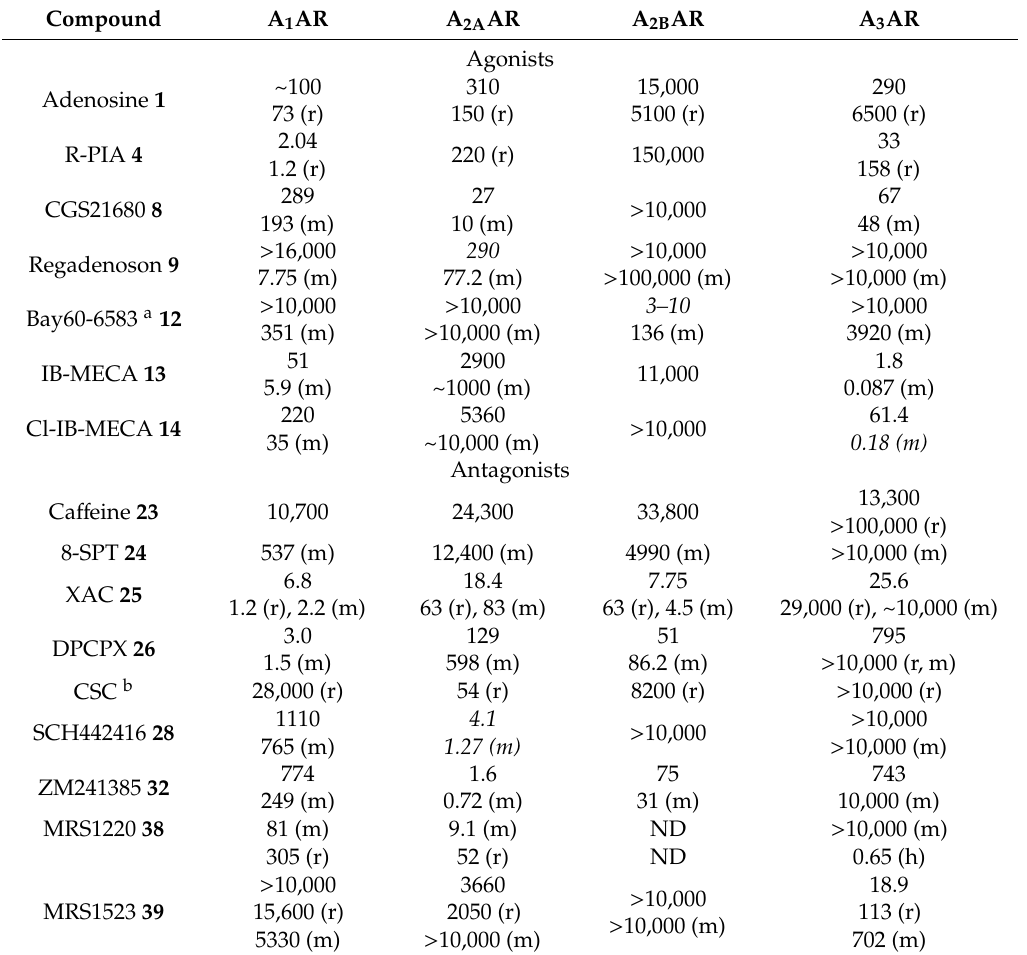
Table 1. A ffi nities of selected AR ligands (K i , nM) that have been used to define adenosinergic activities of non-adenosine receptor drugs (refer to Figure 2 for most structures). Species are human (h), unless noted (m, mouse; r, rat). Values shown and for other compounds in Figure 2 are in Müller and Jacobson; Carlin et al.; Wan et al.; Tosh et al.; Alnouri et al. [22–26]. Values that represent > 100-fold selectivity are shown in bold